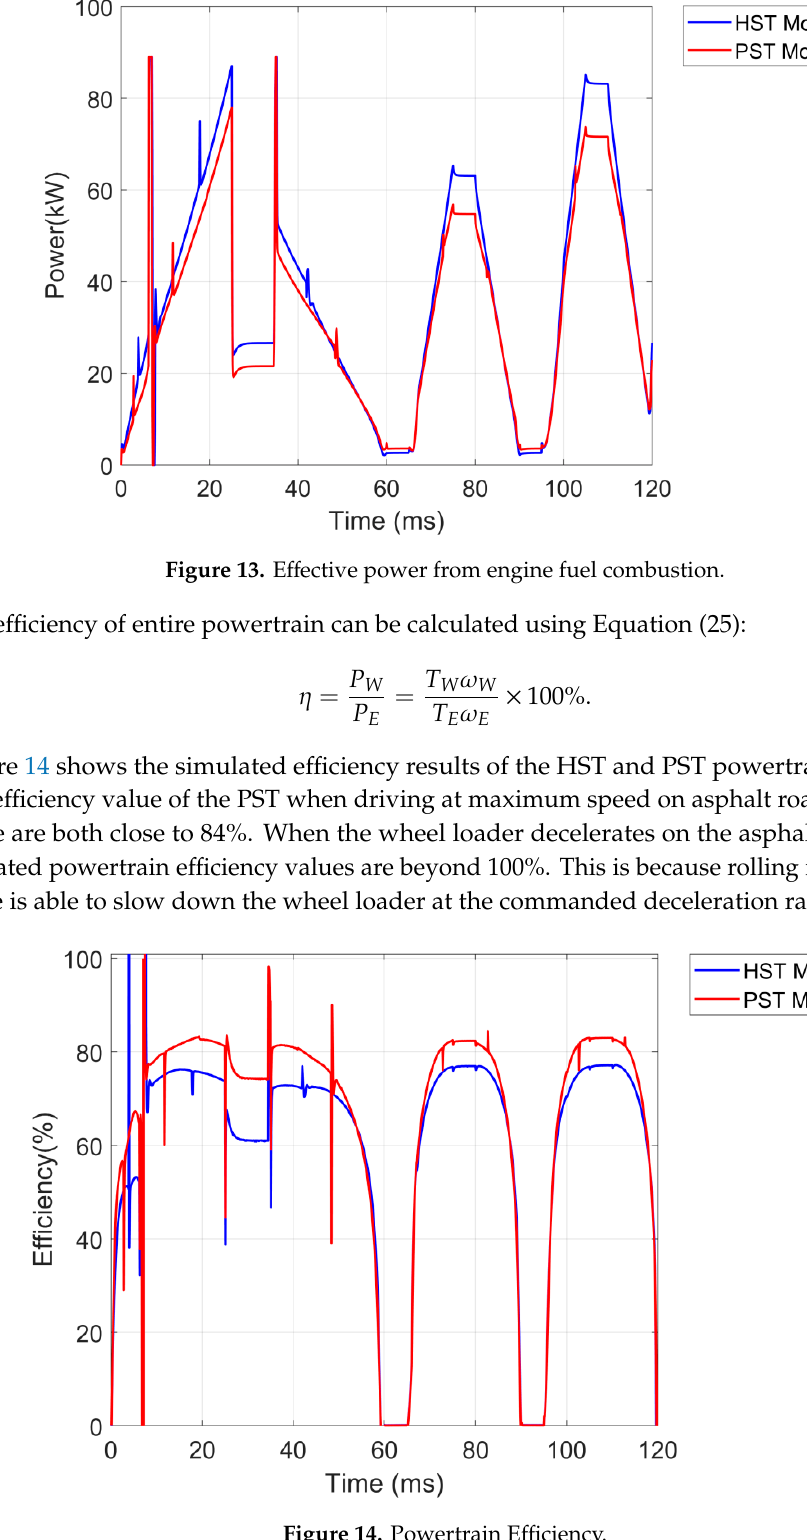
Figure 14. Powertrain Efficiency.